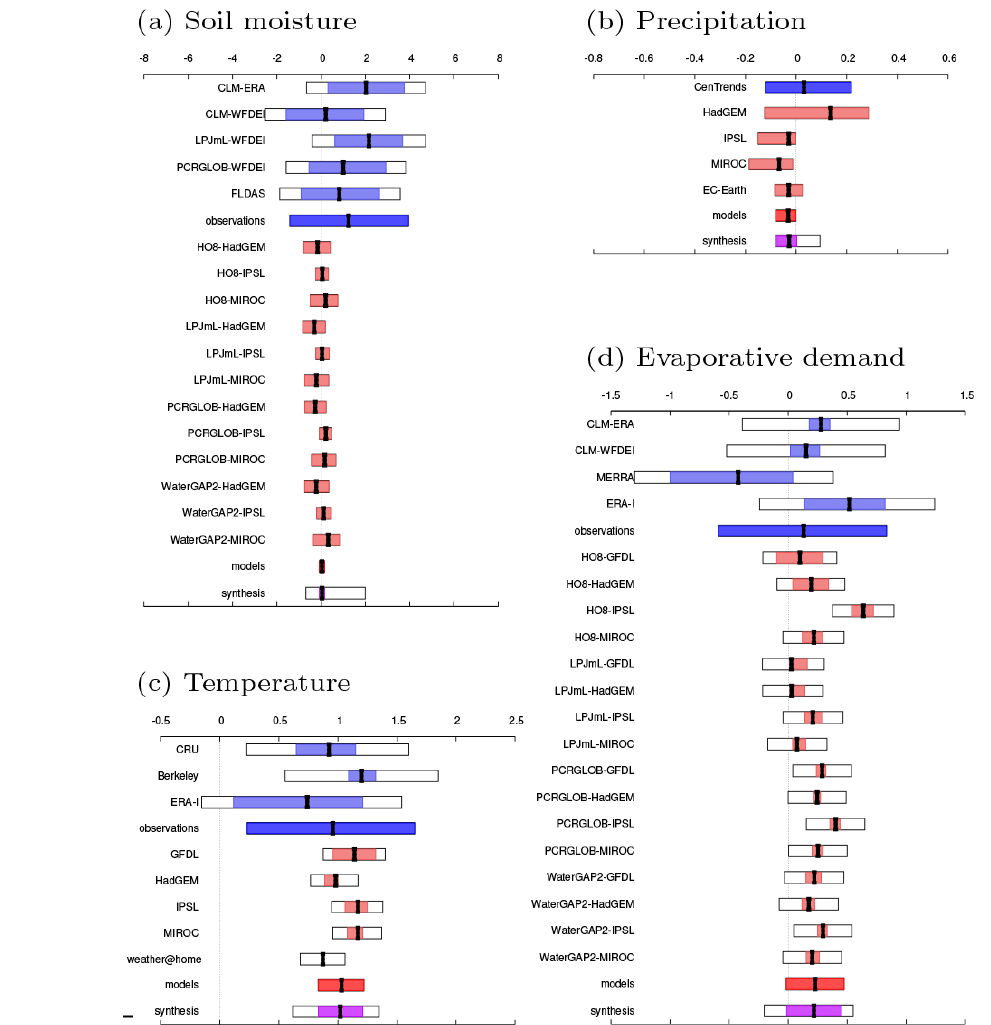
Figure 5. Illustrative examples of the synthesized values of trends per 1K GMST rise for soil moisture [/K] (a) , precipitation [mm/d/K] (b) , temperature [K/K] (c) , and E 0 [mm/d/K] (d) for region SS. Black bars are the average trends, coloured boxes denote the 95% CI. Blue represents observations and reanalyses, red represents models, and magenta represents the weighted synthesis. Coloured bars denote natural variability, and white boxes also take representativity and model errors into account, if applicable (see Sect. 3). In the synthesis, the magenta bar denotes the weighted average of observations and models and the white box denotes the unweighted average. Soil moisture trends are based on standardized data; the other trends are absolute